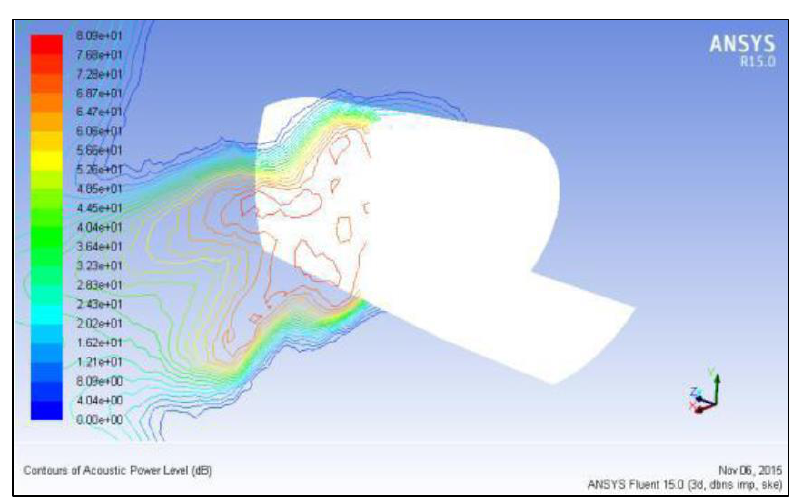
Figure 11. Sound pressure level in X-direction (80 km/h)